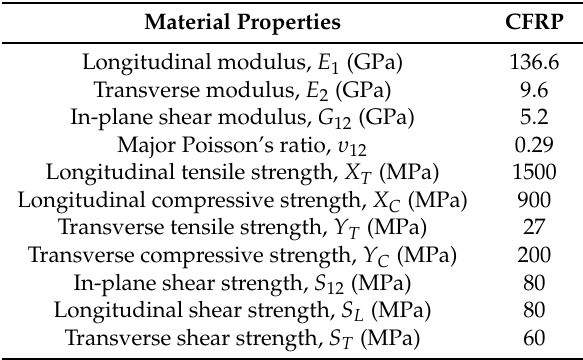
Table 3. Material properties of T300/914 CFRP used in simulation [26–28].